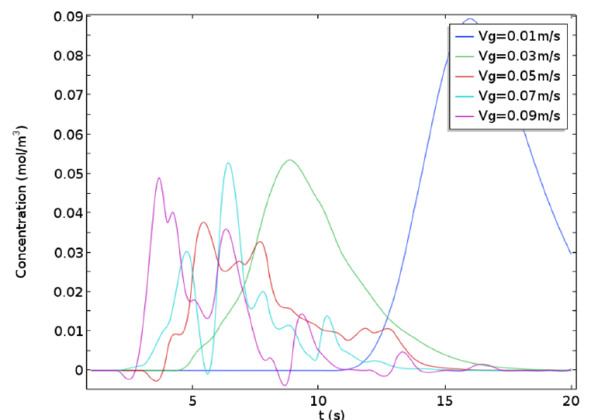
Figure 10. Spectrogram of pressure fluctuations at each branch monitoring point.